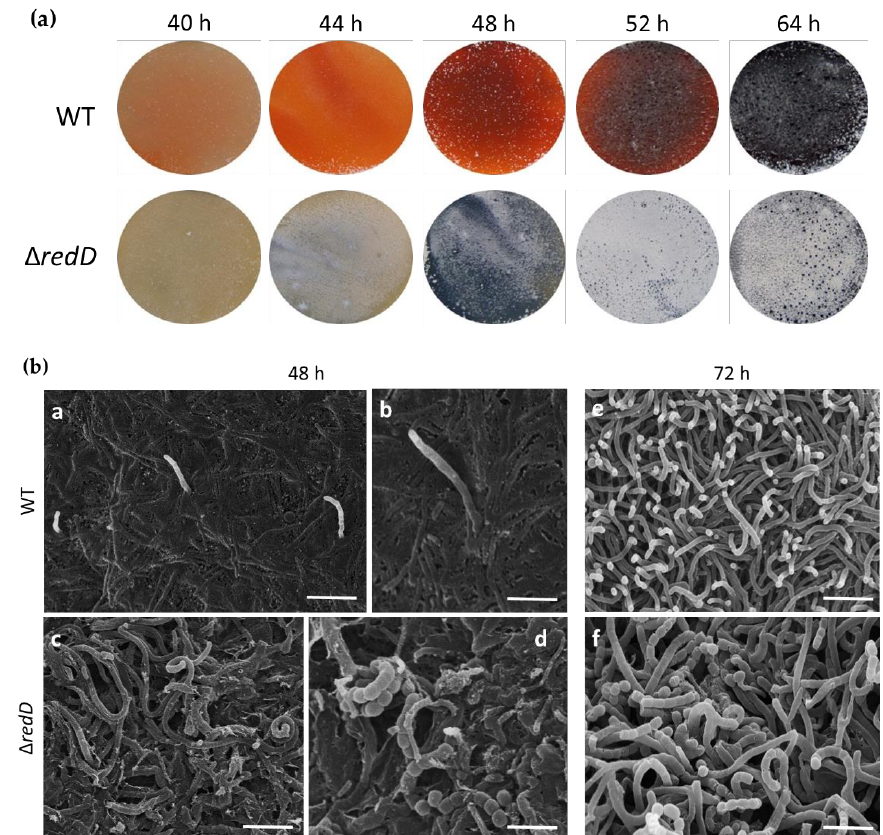
Figure 1. Effect of the redD inactivation on morphological differentiation of S. coelicolor . ( a ) Pictures of R2YE plates inoculated with S . coelicolor M145 (WT, wild-type) and its redD mutant M510. Note the precocious appearance of white-pigmented aerial hyphae. ( b ) Scanning electron micrographs showing precocious sporulation of the S. coelicolor redD null mutant. In ( a , b ) (48 h) we can see in the WT the very first aerial hyphae emerging from the dense network of vegetative filaments while in strain